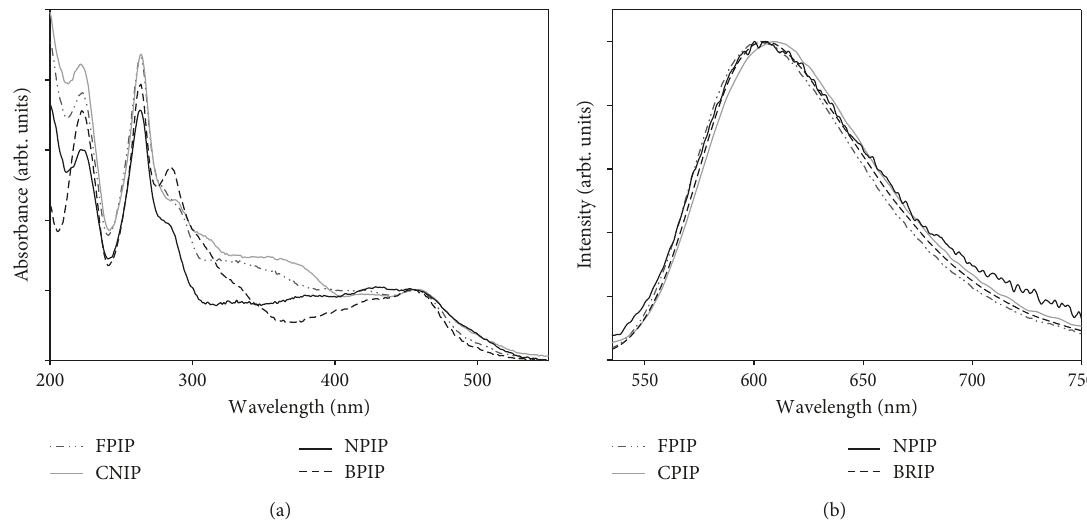
F IGURE 2: UV/Vis absorption (a) and luminescence (b) spectra of ruthenium complexes in acetonitrile with incremented termination group electronegativity for [Ru(phen) 2 L] 2+ .